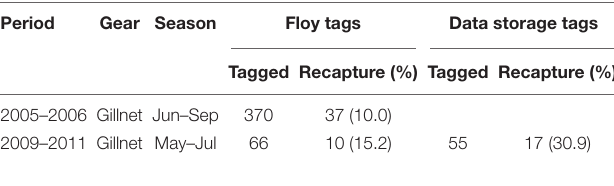
TABLE 2 | Overview of the Faroese mark-recapture project of anglerfish tagged from gillnets north of the Faroe Islands.